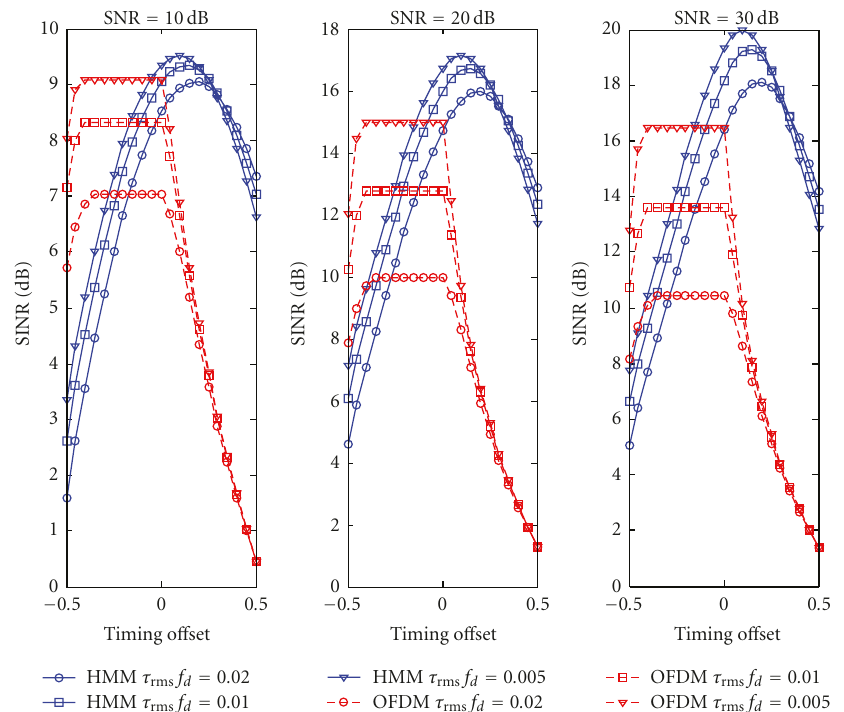
Figure 2: SINR for hexagonal multicarrier system for Δ t ∈ [ − 0 . 5,0 .